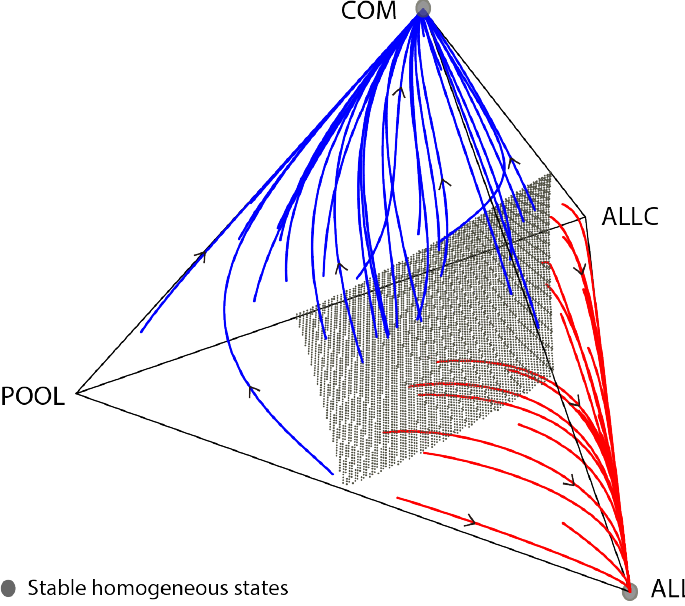
Figure 2. Competition of pool punishment and deposit-based commitment. Populations are attracted to either a state of commitment-based cooperation (COM node) or one of mutual defection (ALLD node). The gray surface separates the basins of attraction for the COM and ALLD nodes. The relative size of the basin of attraction for the COM node is approximately 65% for the specific parameters. In particular, commitment-based cooperation outcompetes coercion-based cooperation (POOL